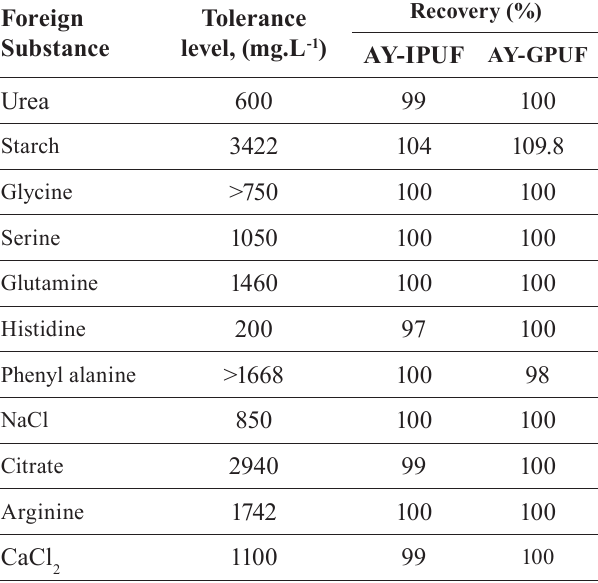
TABLE II - Tolerance levels of CAF (5 mg L -1 ) in the presence of interfering substances